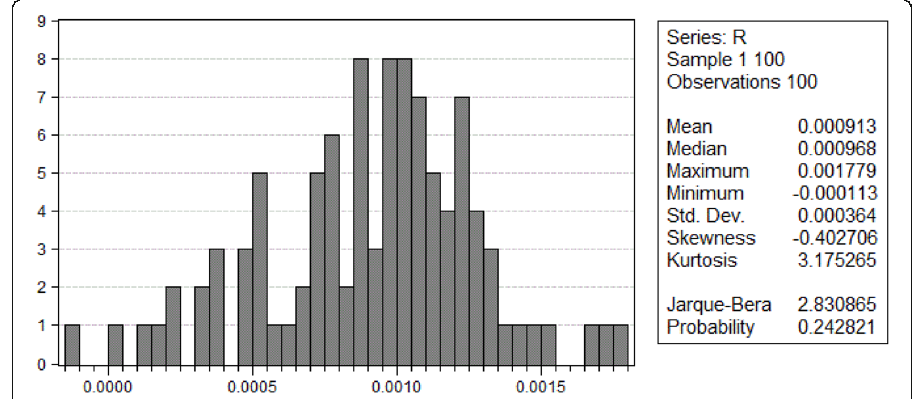
Fig. 5 The distribution and summary statistics of the average simulated return for the AR (1)-GARCH(1,1) process. We use R to denote the average value of the simulated returns. The distribution of R is shown in the left, and the summary statistics are listed in the